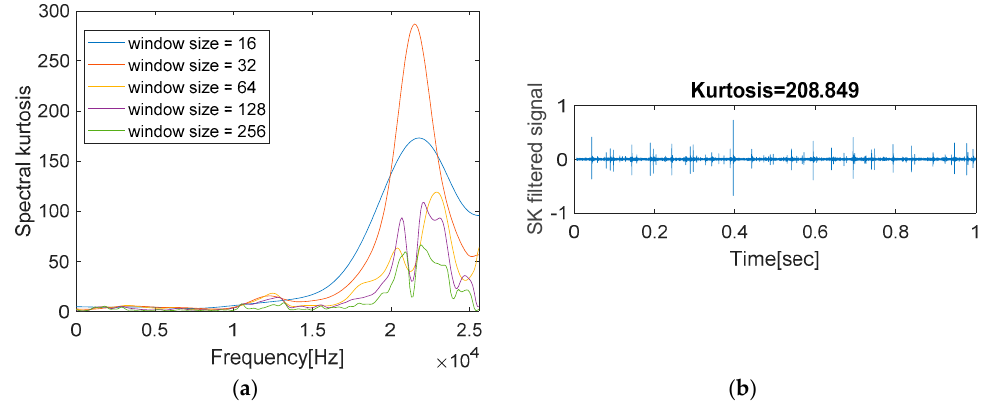
Figure 15. Demodulation band selection for data of bearing 1: ( a ) spectral kurtosis, and ( b ) vibration signal after band-pass filtering.